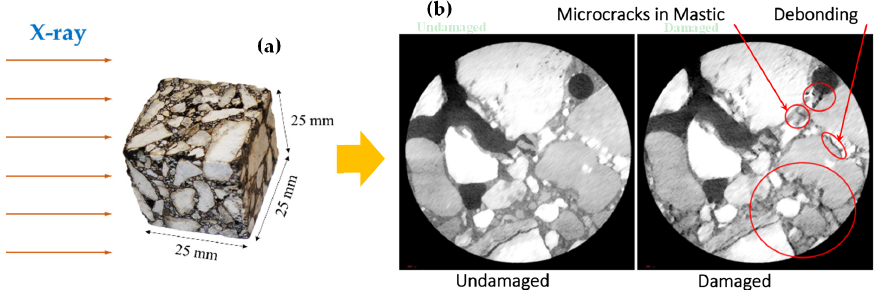
Figure 10. X ‐ Ray micro ‐ computer tomography imaging; ( a ) geometry and dimensions of used asphalt concrete sample; ( b ) images of undamaged (left) versus thermally damaged (right) asphalt concrete sample showing damaged regions.